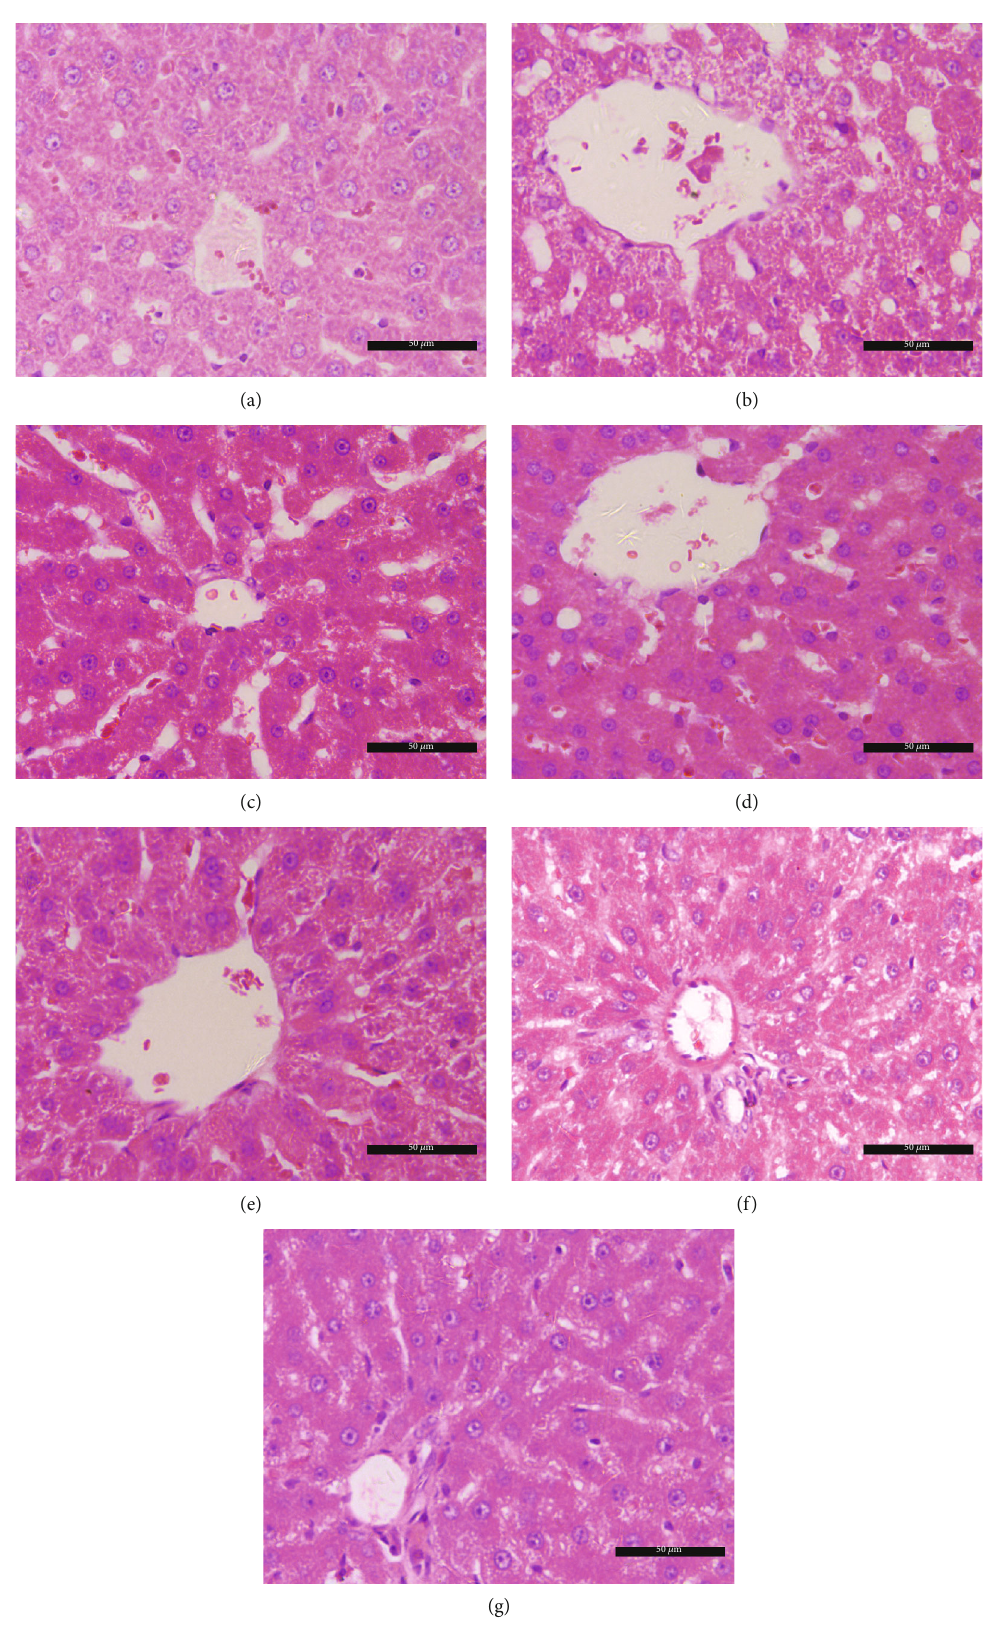
Figure 2: Berberine decreases the hepatic lipid accumulation. (a) Control group, (b) model (DM) group, (c) glimepiride group, (d) metformin group, (e) glimepiride+metformin group, (f) berberine (150mg/kg) group, and (g) berberine (300mg/kg) group. Scale bars, 50 μ